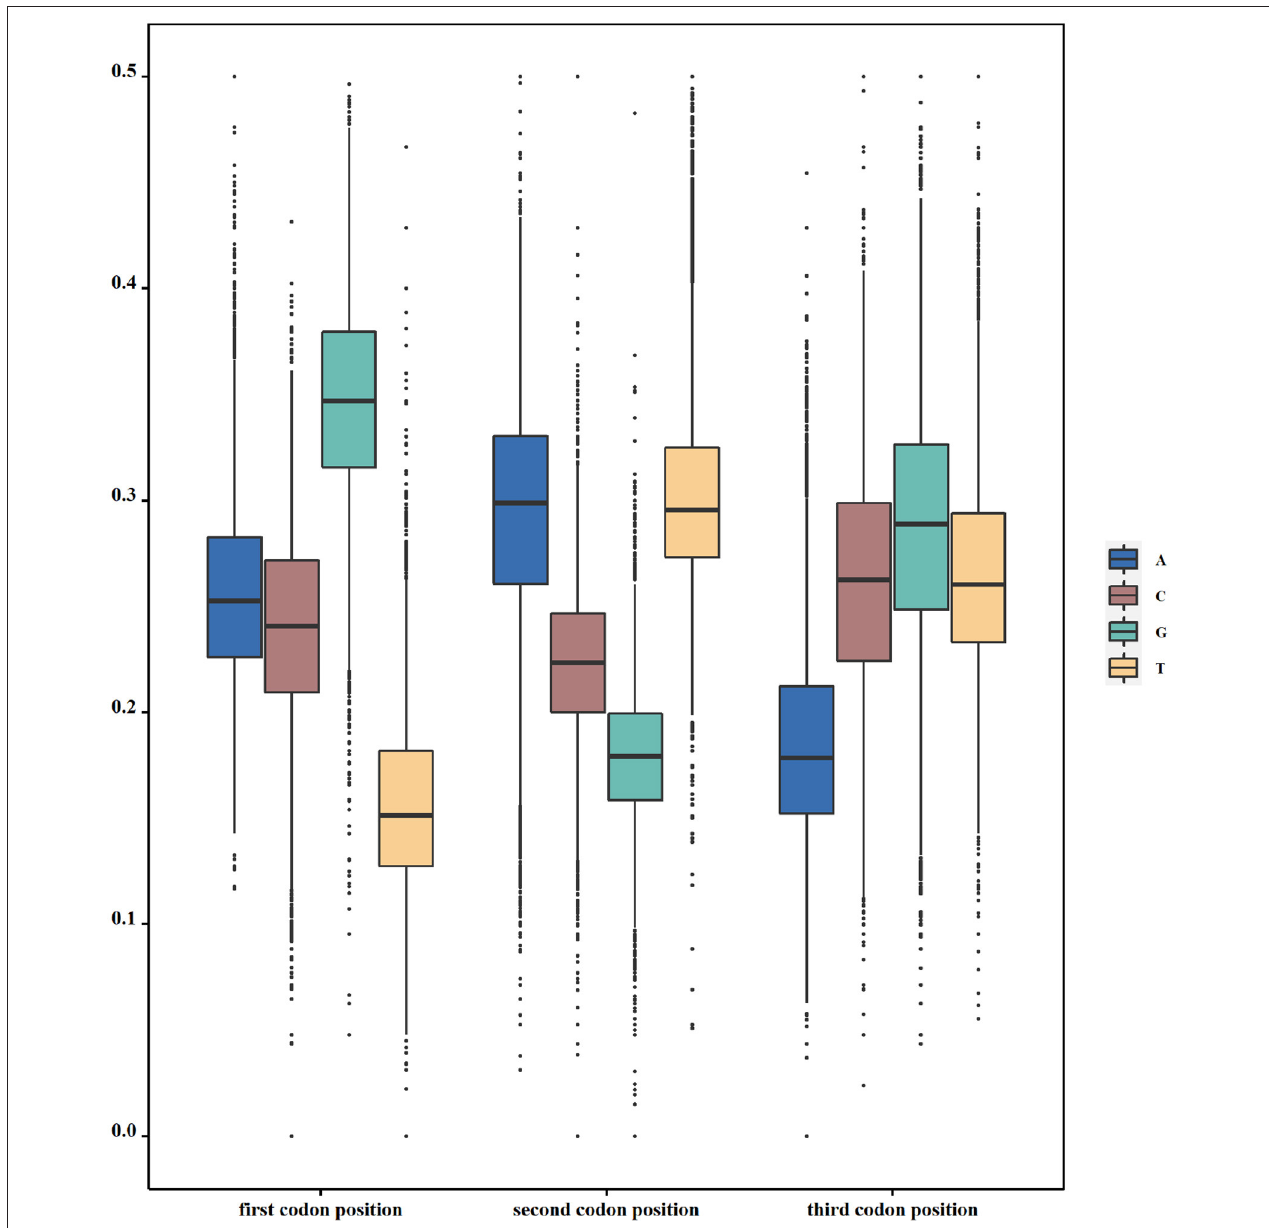
FIGURE 1 | Usage of nucleotides in triplet codons. The y axis denotes the frequency of one specific nucleotide at one specific codon position. In Escherichia coli ( E. coli ), T, G, and A are used the least at the first, second, and third positions of triple codons, respectively.